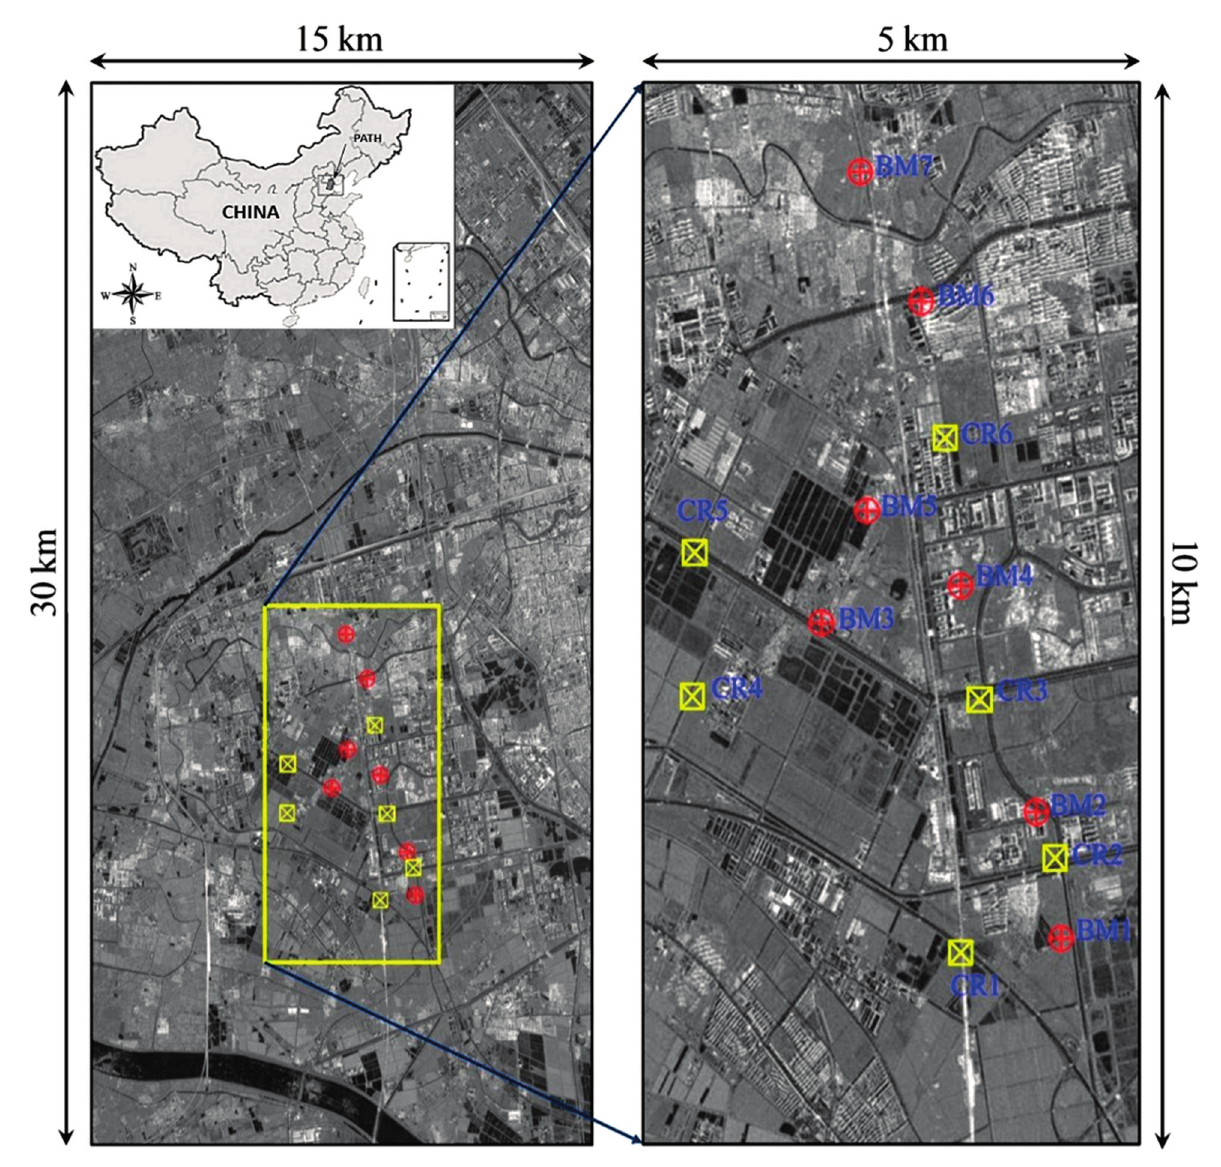
Figure 5. The location map and the study area around Tianjin in China. The insert at the top- left corner shows the location map and the coverage of the TSX scenes. The left panel shows the amplitude image (averaged from 40 TSX images) in which the study area is marked by the rectangle. The right panel shows the enlarged amplitude image of the study area in which the seven benchmarks (BMs) and six corner reflectors (CRs) are annotated for later